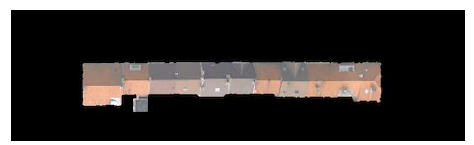
Figure 7 . Rotation of building block to the inverted complement of angle of the dominant